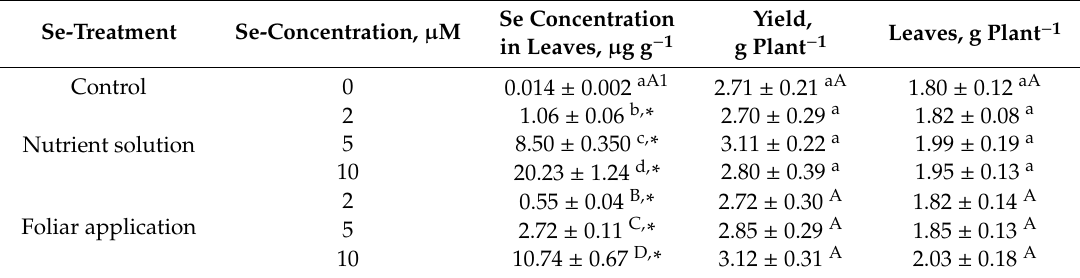
Table 1. E ff ect of type and concentration of Se application on selenium concentration in basil leaves and yield of whole plants and leaves.